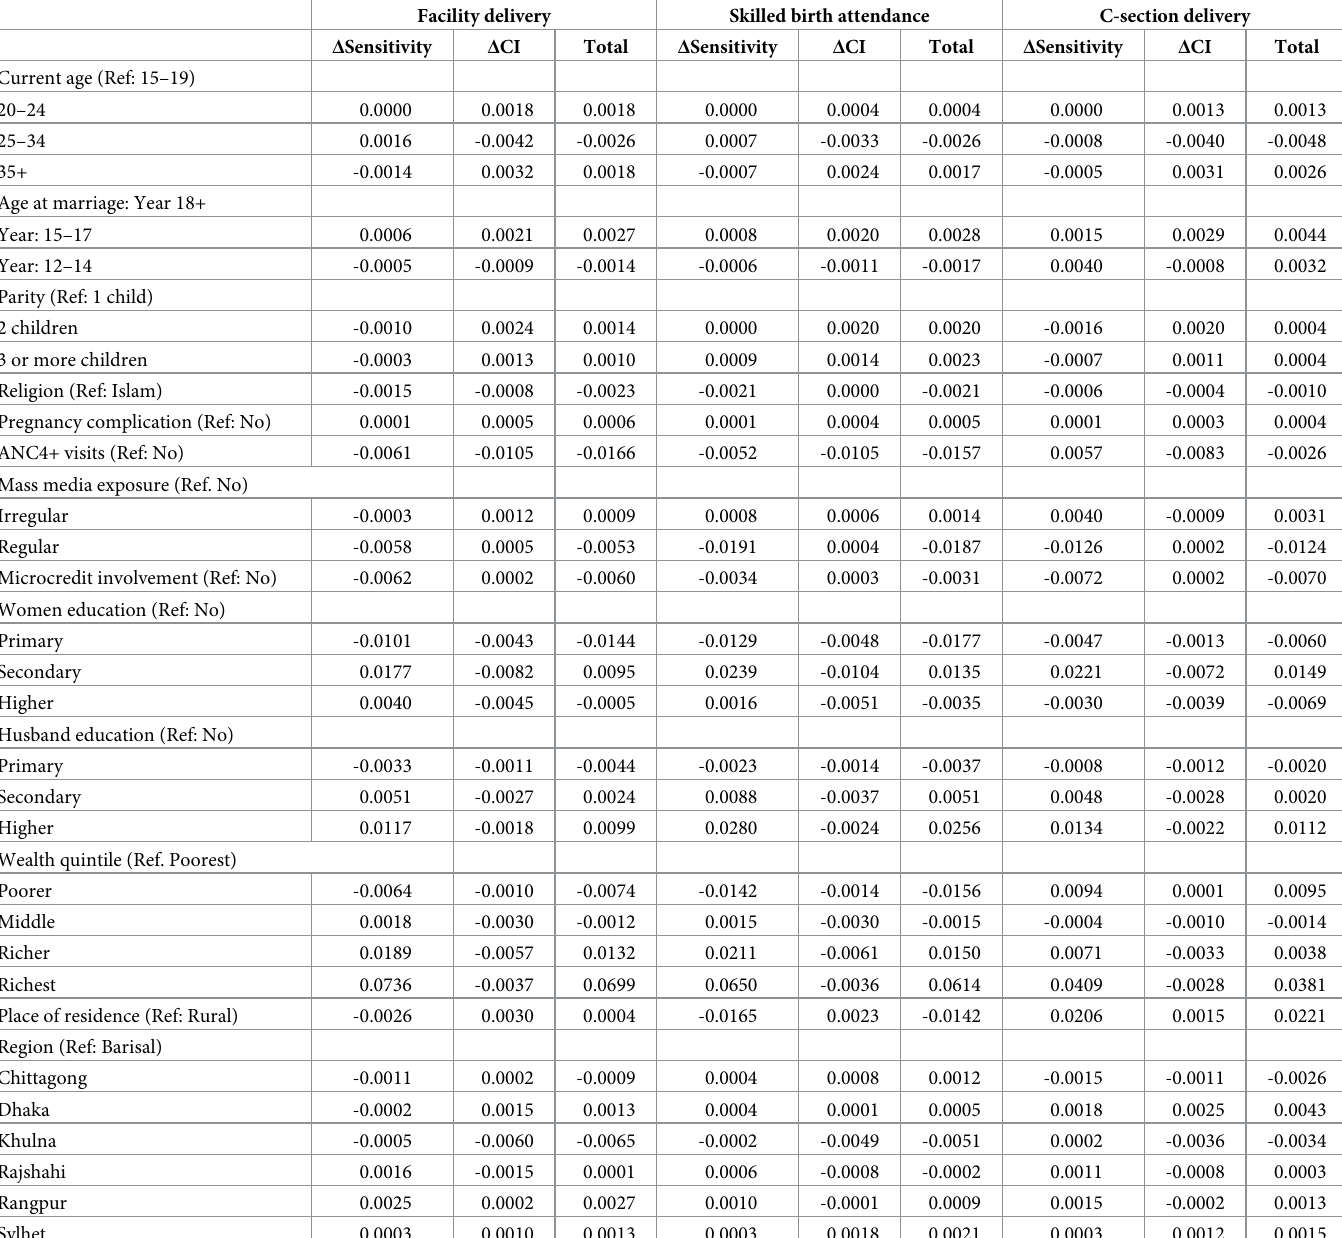
Table 5. Changes in the contributing factors of inequalities in delivery care service use (decomposition of the